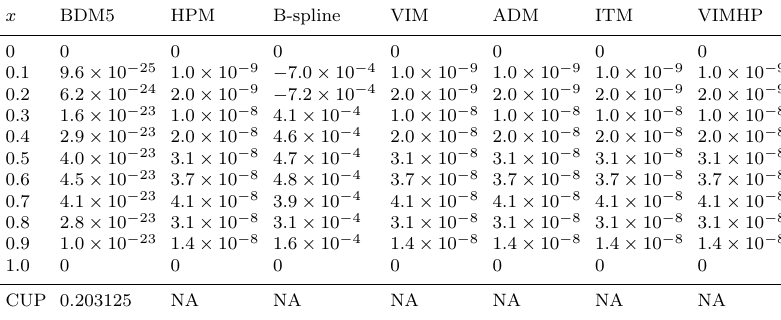
Comparison of observed absolute errors on Example 4 using BDM5 and the methods in [8] with h = 1 / 10.